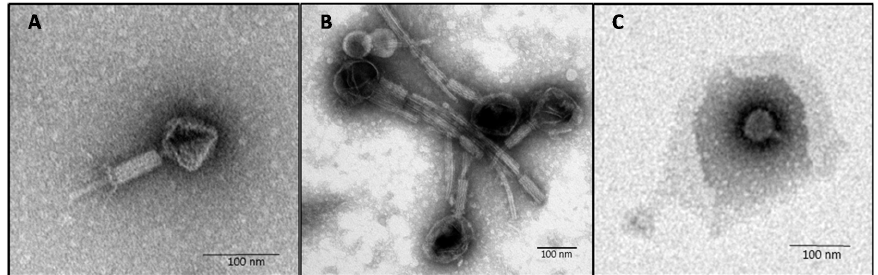
Figure 1. Electron micrograph images of phage SL1 ( A ); SL2 ( B ); and SL4 ( C ) infecting P. aeruginosa , negatively stained with: 0.5% uranyl acetate ( A , B ); or 1% phosphotungstic acid ( C ).